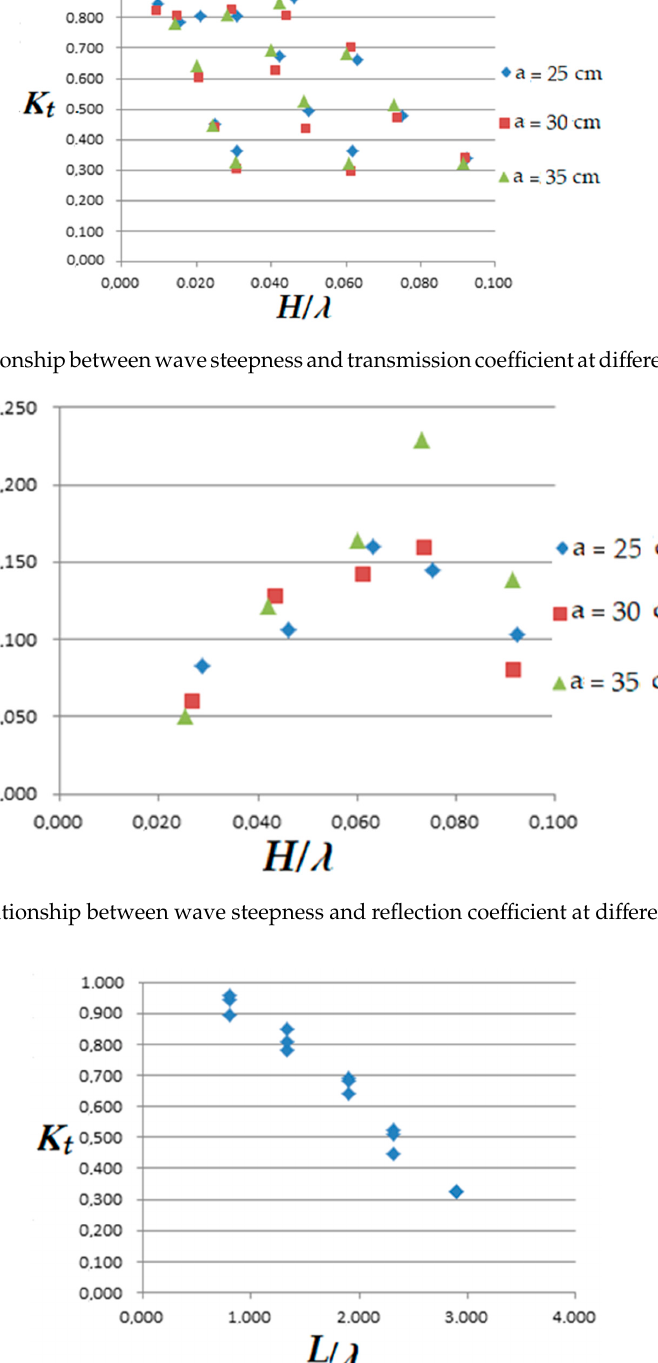
Figure 11. Relationship between wave steepness and transmission coefficient at different plate lengths.